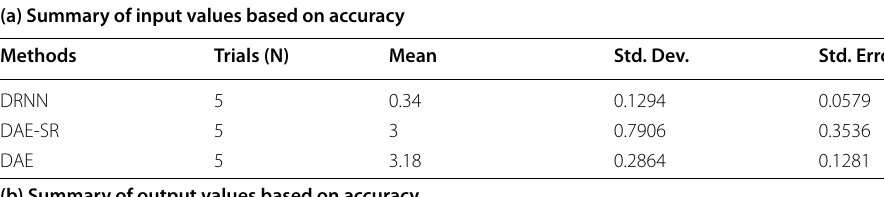
(b) Summary of output values based on accuracy Source